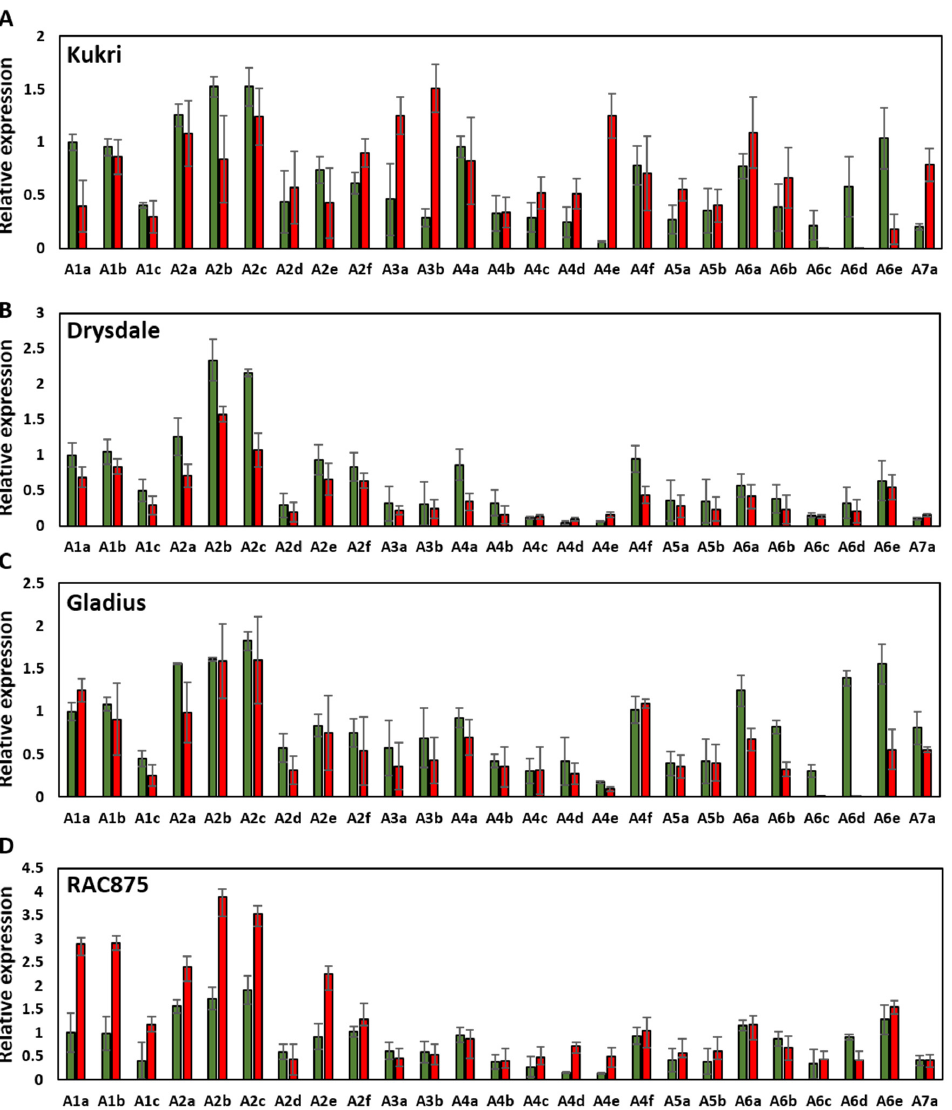
Figure 5. Relative mRNA expression levels of class A heat shock factor genes ( TaHSFs ) in anthers of Australian summer wheat varieties comparing heat stressed and control plants. A tubulin gene was used as a housekeeping gene for normalization. Expression values were set in relation to the average expression level of A1a HSF. Kukri ( A ), Drysdale ( B ), Gladius ( C ), and RAC875 ( D ). Green and red bars represent non ‐ and heat ‐ stressed plants, respectively. Values are means ± SD of three biological replicates.